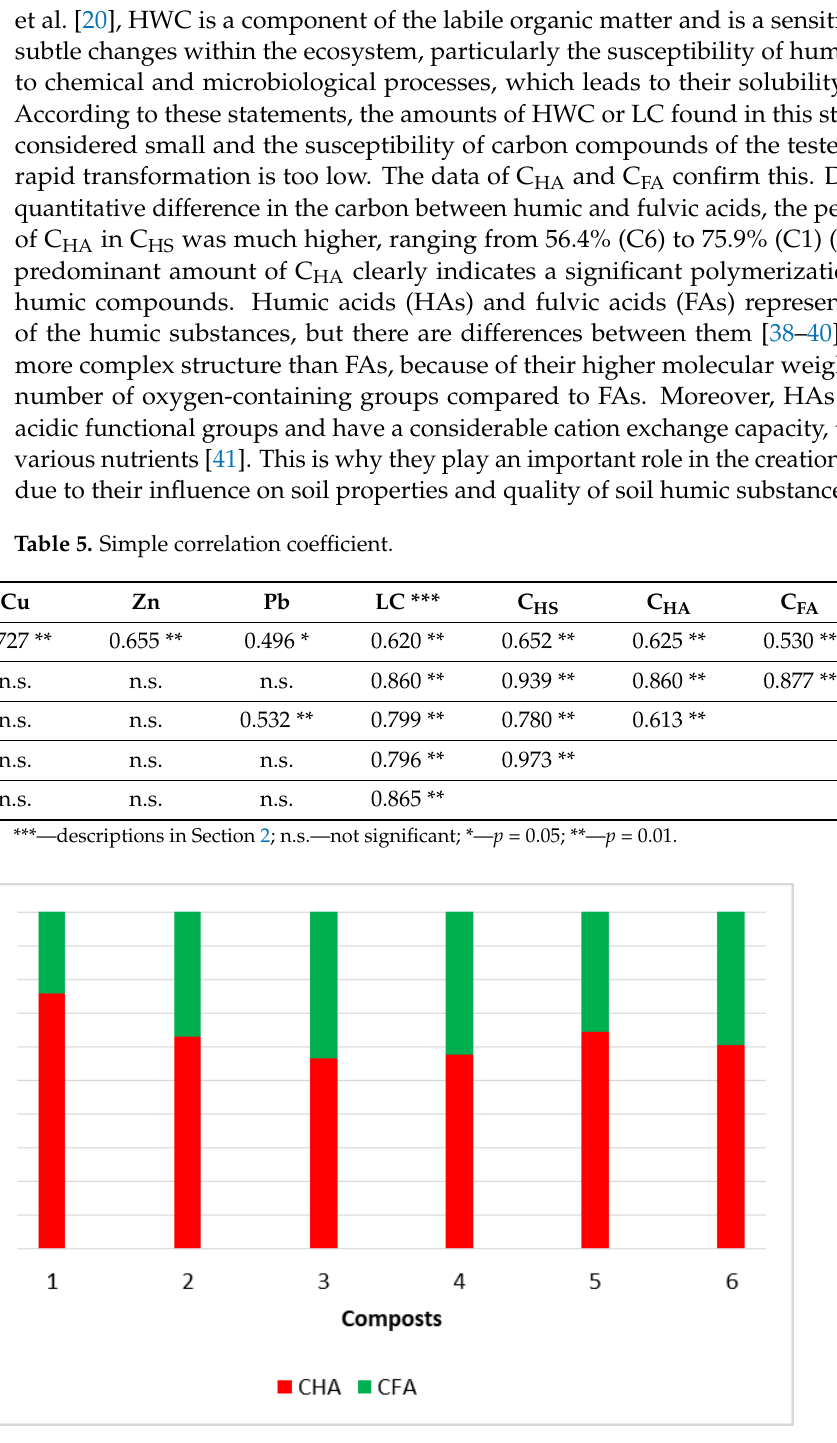
Figure 2. Percentage shares of carbon of humic (C HA ) and fulvic acids (C FA ) in humus substances. Table 5. Simple correlation coefficient.